Question: Briefly state, in one sentence, what is plotted here.
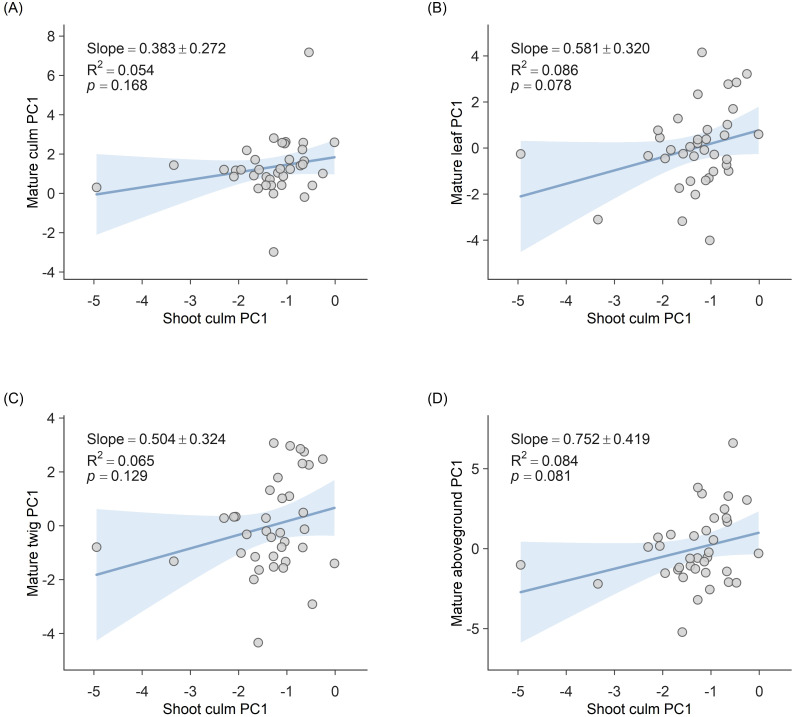
Answer: Relationships between shoot-culm PC1 and (A) mature culm PC1, (B) mature leaf PC1, (C) mature twig PC1, and (D) mature aboveground PC1. Lines indicate fitted linear regressions, and shaded areas represent 95% confidence intervals. Each point represents a plot mean.